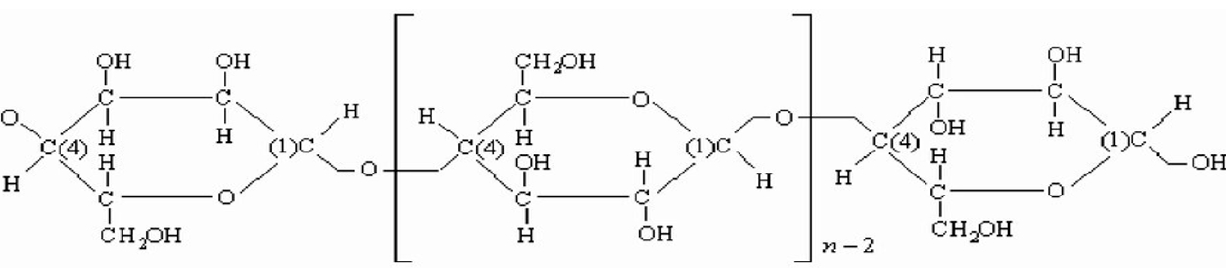
Figure 4. SEM analysis of the microstructure of surfaces of original ( a , b ) and burnt ( c , d ) apricot kernel shell biomass.